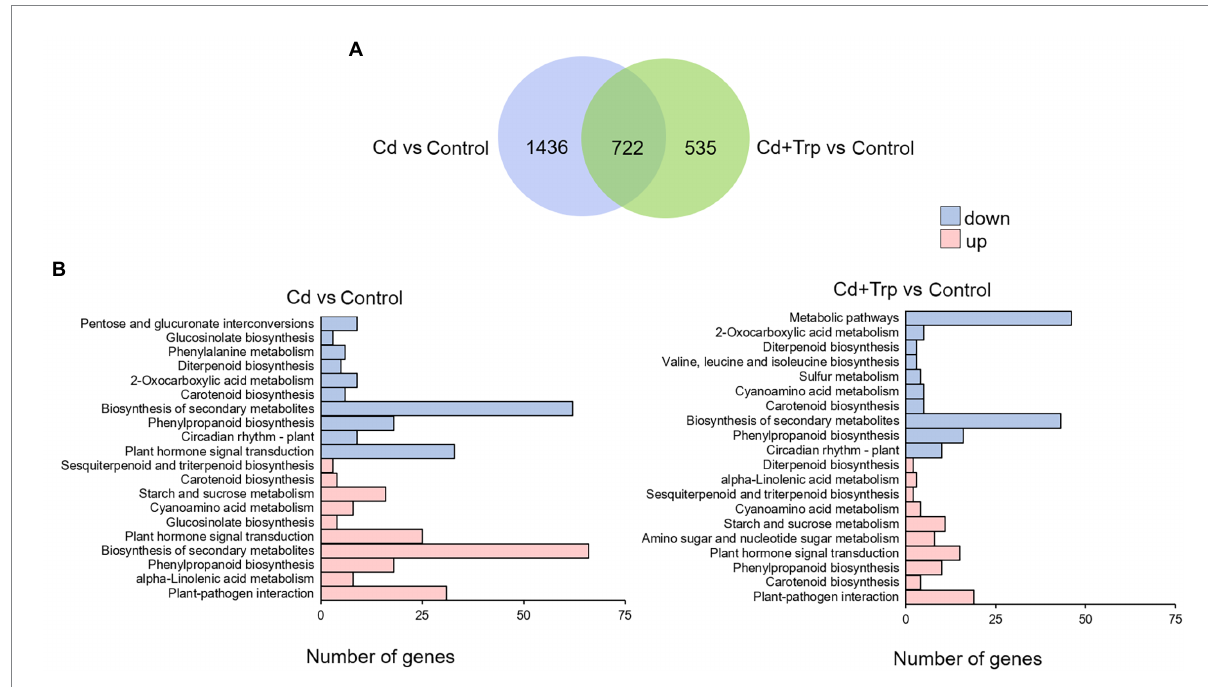
FIGURE 5 Analysis of differentially expressed genes (DEGs) and KEGG enrichment under Cd stress with or without Trp applicaiton. (A) Venn diagram of the distribution of DEGs responsive to Cd stress with or without Trp application. (B) KEGG pathway enrichment analysis of DEGs responsive to Cd stress with or without Trp